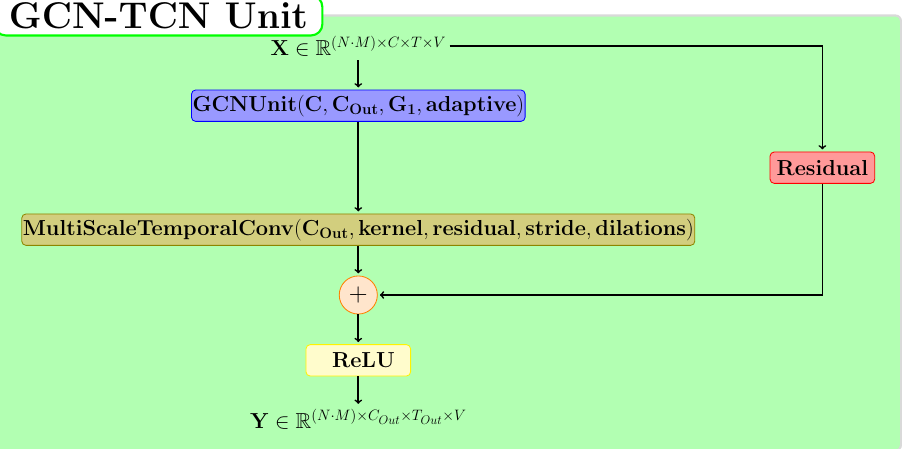
Figure 6. The proposed structure for the TCN-GCN